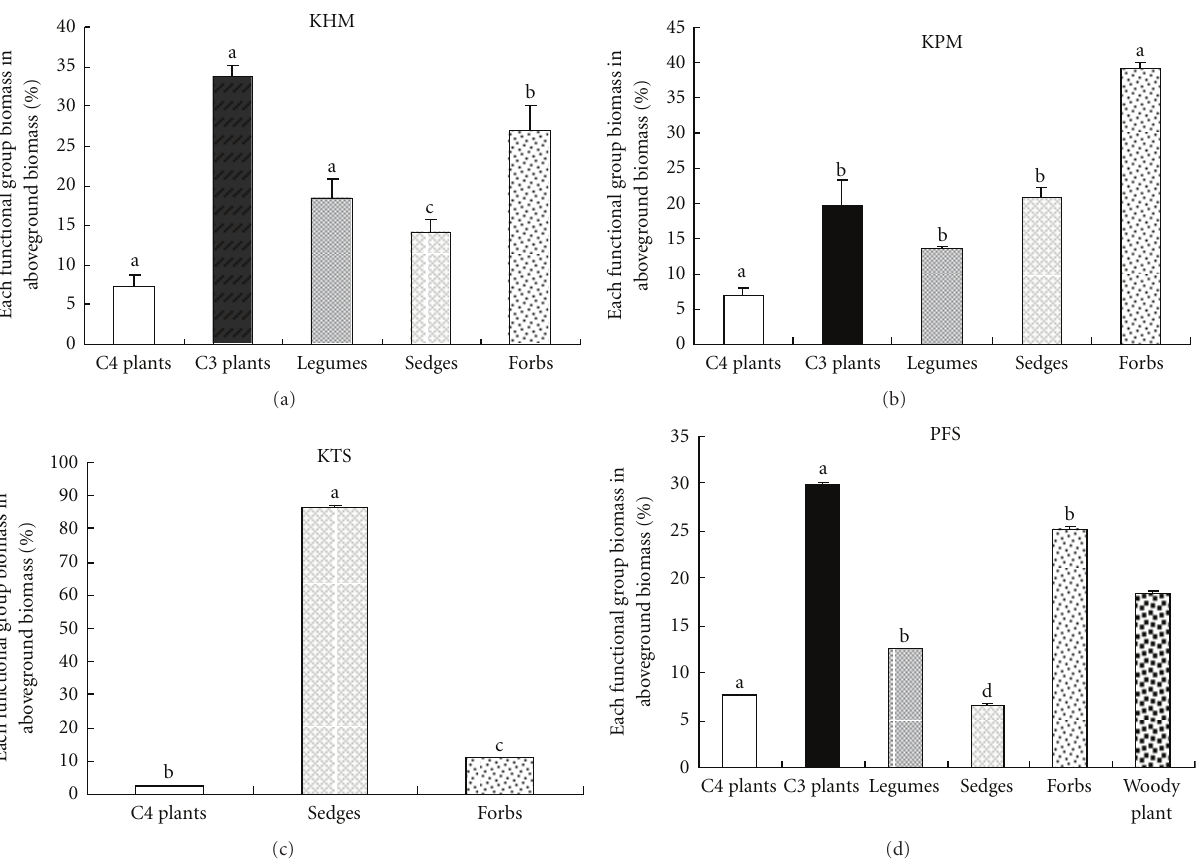
Figure 2: Distribution of biomass (Mean ± SD, n = 10, g/m 2 ) in the KHM, KPM, KTS, and PFS communities. The percent of each functional group in the total aboveground biomass is indicated above the X -axis. At the same functional group biomass percent for di ff erent community, values with the same letters are not significantly di ff erent ( P ≤ . 05) (one-way ANOVA analyses for forbs, C 4 plants, C 3 plants, sedges, and legumes). Kobresia humilis meadow = KHM; Kobresia pygmaea meadow = KPM ; Kobresia tibetica swamp meadow = KTS ; Potentilla fruticosa scrub = PFS .